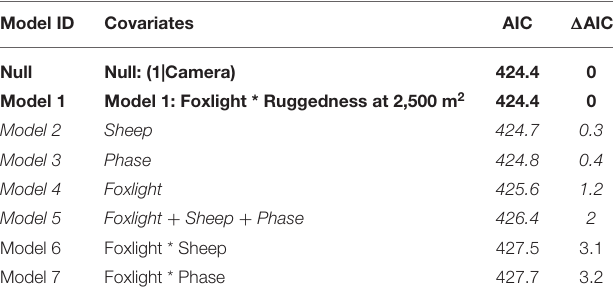
TABLE 3 | Model selection for coyote detections across Foxlight phases.